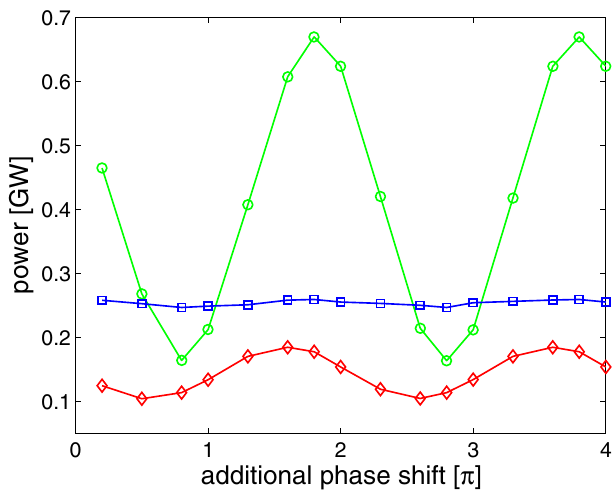
FIG. 6. (Color) Power fluctuations at the exponential growth region as a function of the additional phase shift (see text for (cid:1) 0 : 3 (cid:8) m in single frequency details) based on an optimal R 56 mode (green line with circle marks), in SASE mode based on an (cid:1) 0 : 3 (cid:8) m (blue line with square marks), and in optimal R 56 (cid:1) 0 : 1 (cid:8) m (red line with dia- SASE mode with a reduced R 56 mond